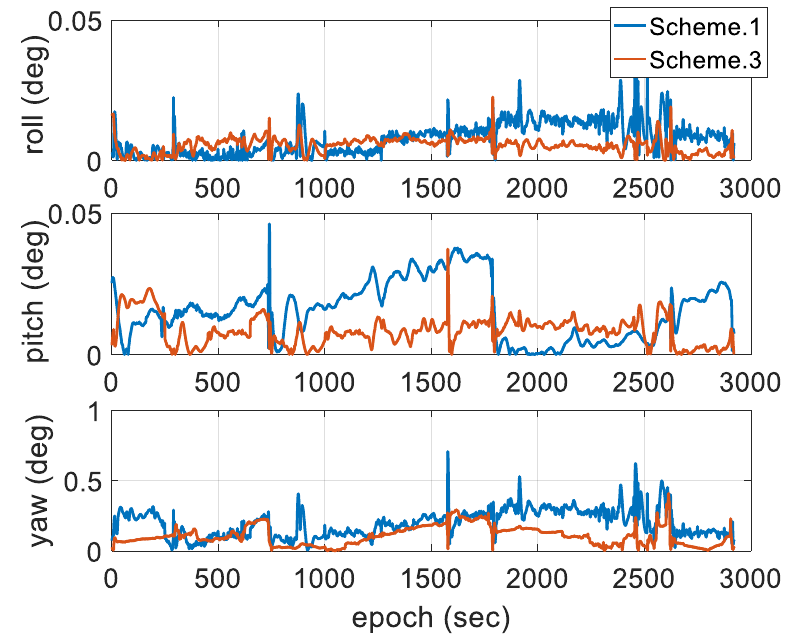
Figure 13. Comparisons of attitude error.